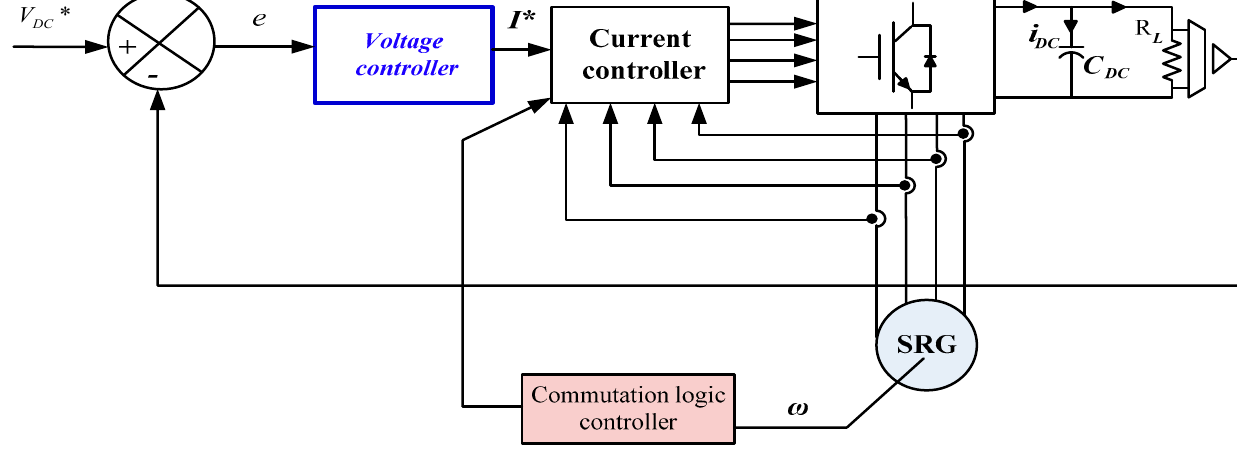
Figure 6. Proposed control strategy of SRG.